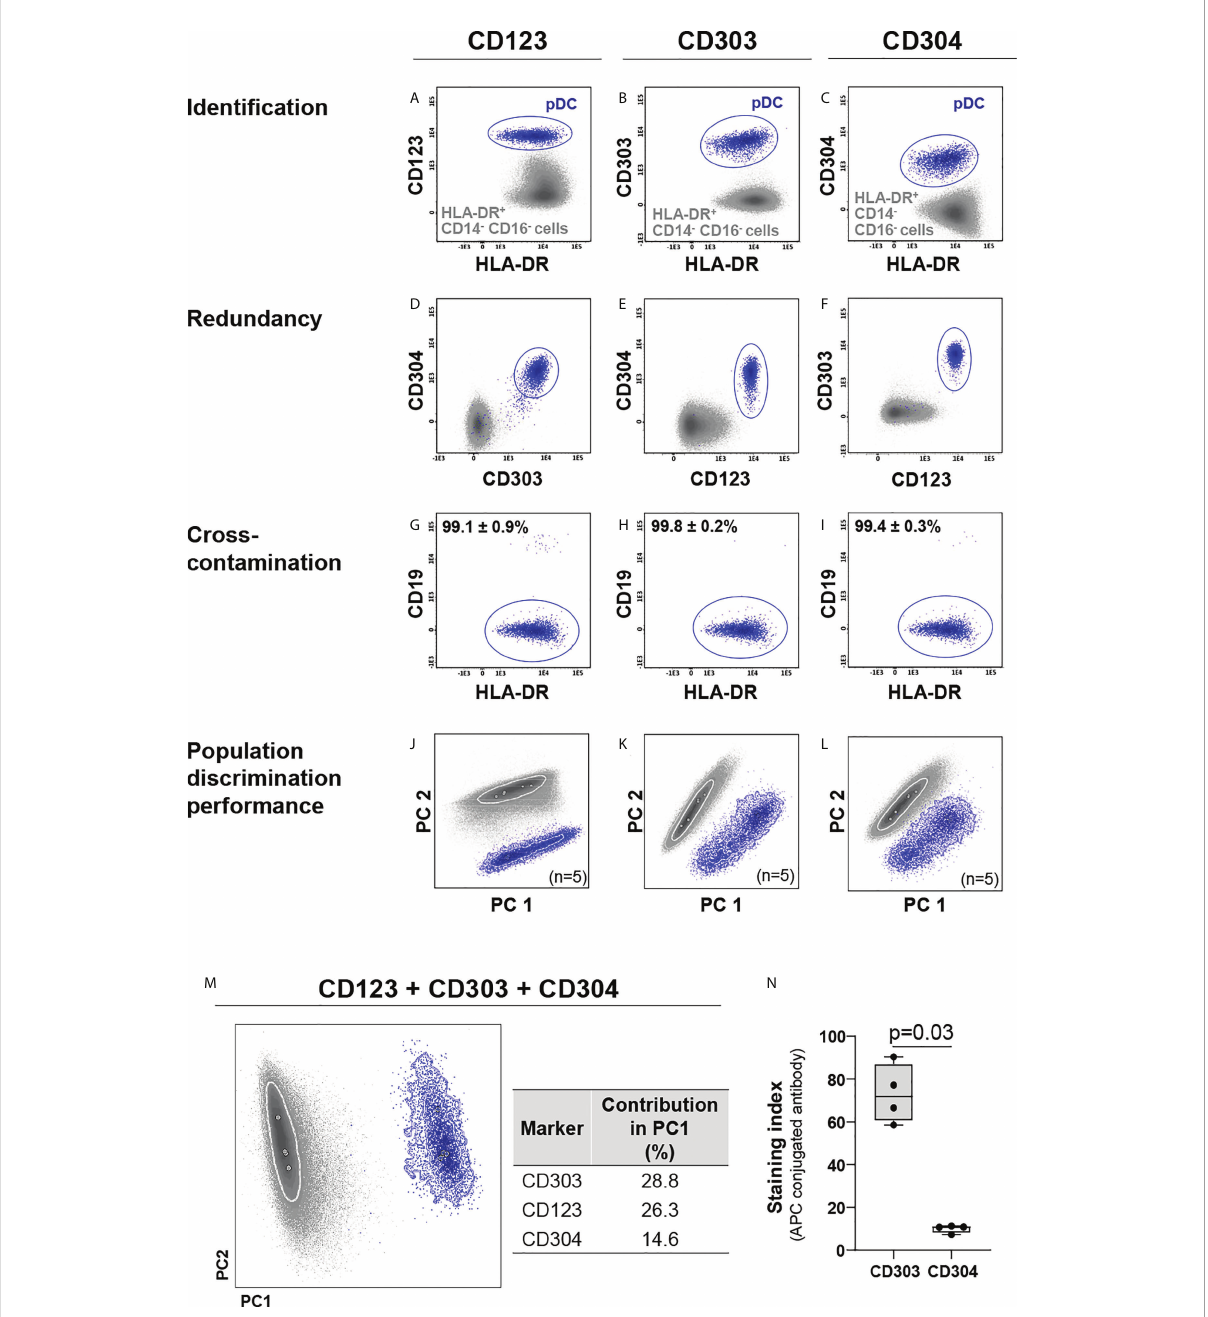
FIGURE 1 Comparison of the performance of CD123, CD303 and CD304 for identi fi cation of plasmacytoid dendritic cells (pDCs). CD123, CD303 and CD304 were individually employed for identi fi cation of pDCs (A – C) within the HLA-DR+ CD14- CD16- cell population. Redundancy of each marker vs. the other two (D – F) and cross-contamination of pDCs with other cells (G – I) , were evaluated. Marker performance for discrimination of pDCs vs. other HLA-DR+ CD14- CD16- cells was determined using principal component (PC) analysis (PCA) in the context of cross-staining with CD14, CD16, CD45, CD300e, HLA-DR for the individual markers (J – L) and in the combination of all markers (M) . The contribution of CD123, CD304 and CD303 to the separation of pDCs vs. other HLA-DR+ CD14- CD16- cells is depicted in the table. (N) exhibits the staining index of allophycocyanin (APC)-conjugated CD303 and CD304 reagents. To test differences, the Mann-Whitney test was used. Solid circles in all PCA plots represent median values for the parameters evaluated and dotted lines depict the fi rst standard deviation for each population identi fi ed. pDC, plasmacytoid dendritic cells; PC, principal component; APC,